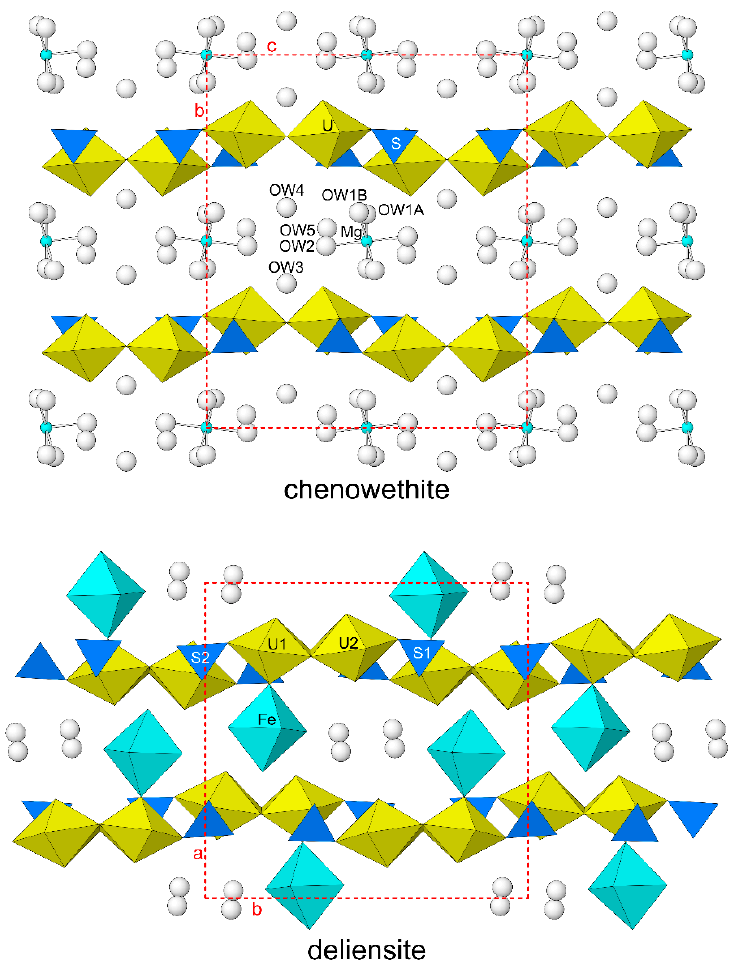
Figure 6. The structures of chenowethite and deliensite. The unit cell outlines are shown by dashed red lines with cell directions labeled in red.